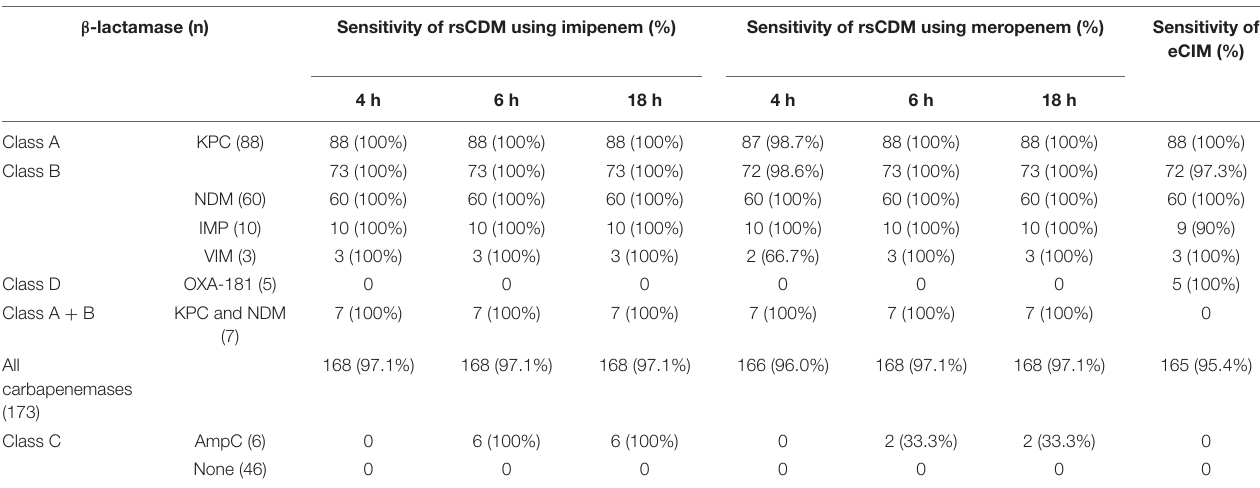
TABLE 1 | Performances of the rsCDM and eCIM tests in Enterobacterales strains. β -lactamase (n) Sensitivity of rsCDM using imipenem (%) Sensitivity of rsCDM using meropenem